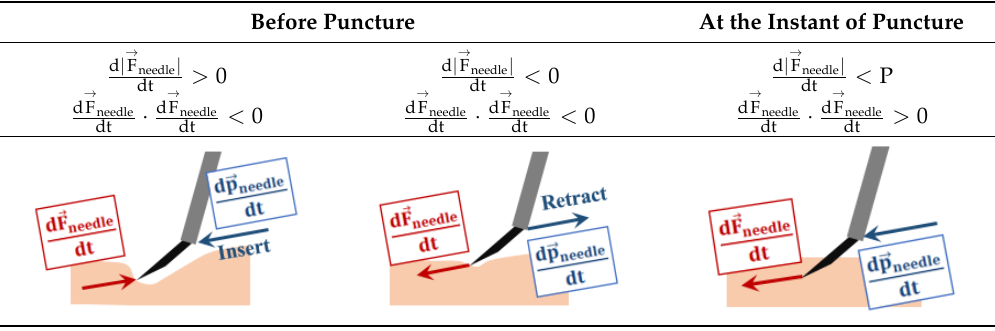
Table 1. Variation of tool tip force and position before and at the instant of puncture. Before Puncture